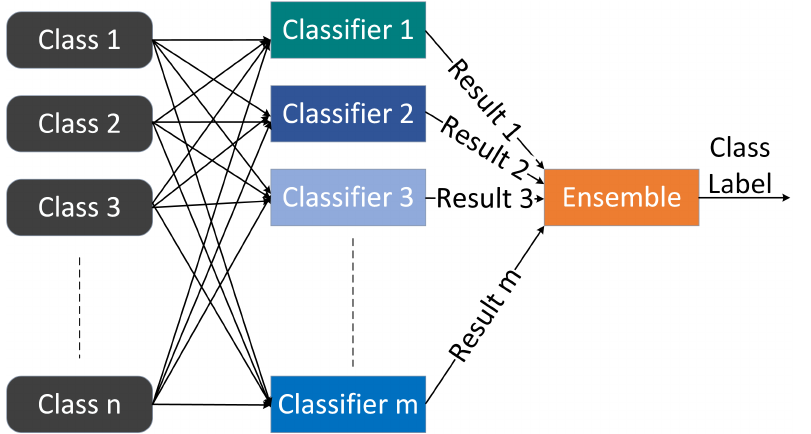
Figure 3. General architecture of an ensemble